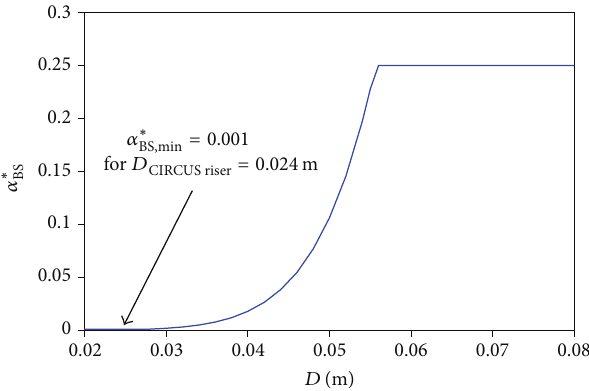
Figure 5: RELAP5 bubbly-to-slug transition boundary depending on the pipe diameter at 𝐺 𝑚 ≤ 2000 kg / m 2 s.